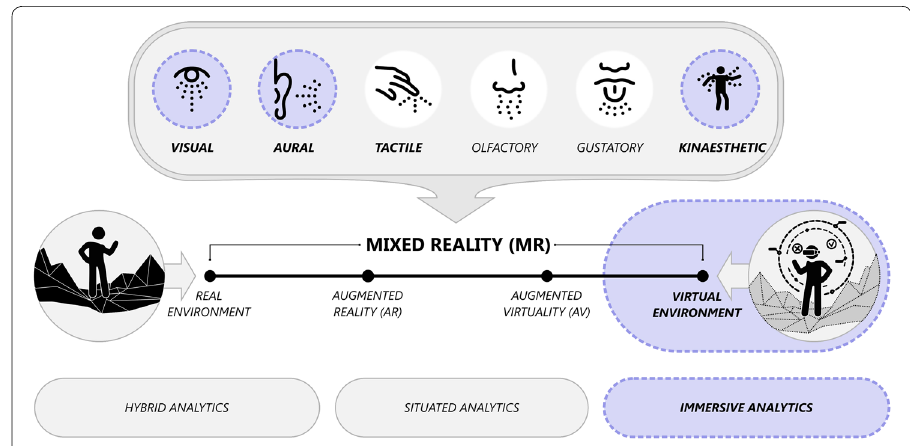
Fig. 1 Reality continuum [32], extended to include senses (blue shading indicates research